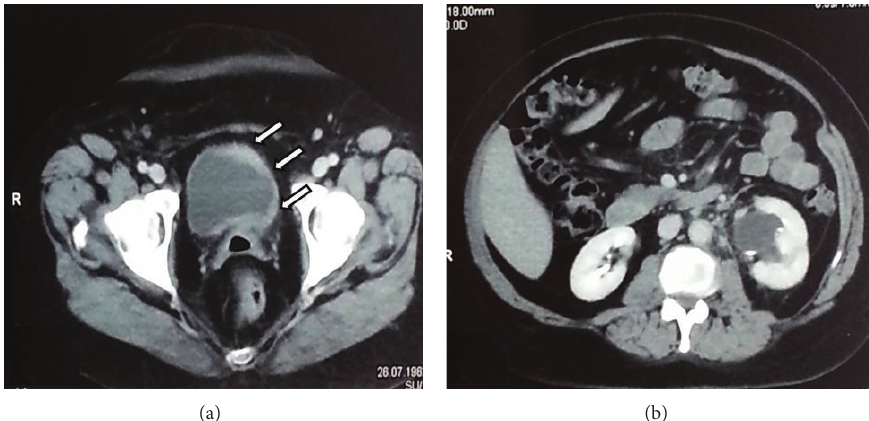
Figure 1: Abdominal computed tomography scanning showing (a) thickening of the left bladder wall (arrows) with grade II left hydronephrosis (b).